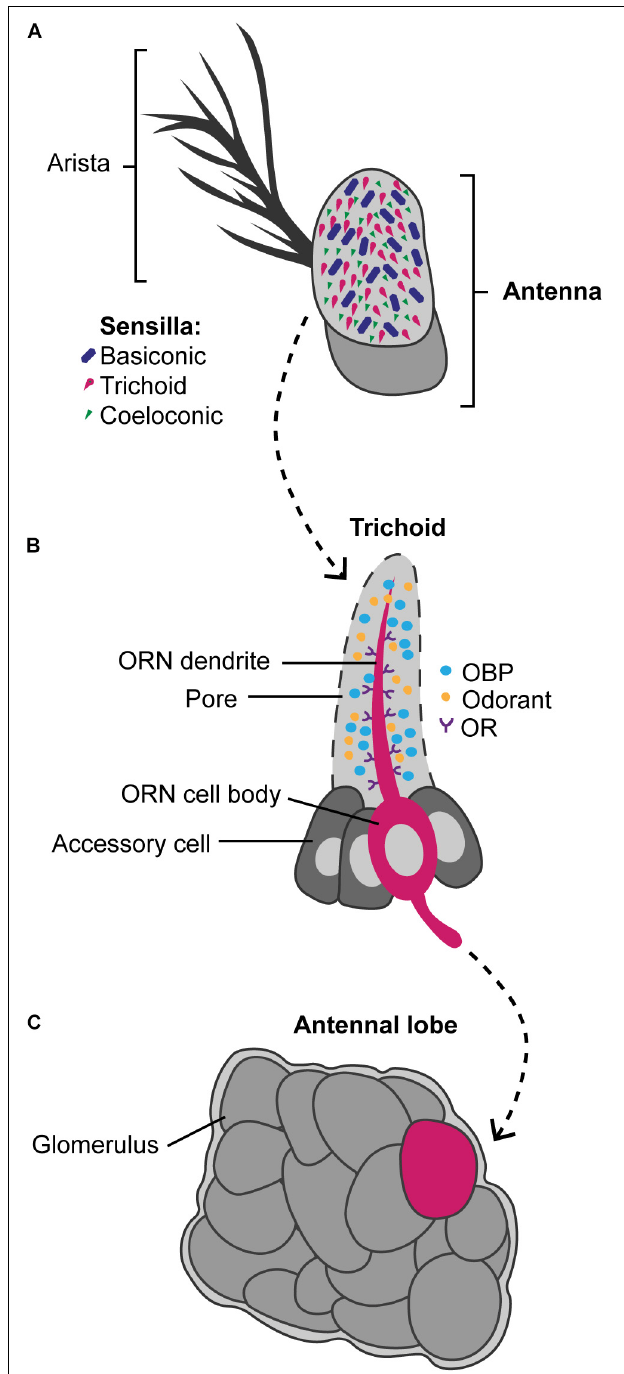
FIGURE 3 | A simplified overview showing how odors are detected by the olfactory pathway. Odors are detected by hair-like sensilla on the antennae and the maxillary palps. Panel (A) exemplifies how the antennae of Drosophila are covered with the basiconic (blue), trichoid (magenta), and coeloconic (green) sensilla types. These sensilla contain olfactory receptor neurons (ORN) that express olfactory receptors (ORs) and ionotropic receptors (IRs). Panel (B) exemplifies a trichoid sensilla in which the dendrite of the ORN (magenta) is covered with ORs (purple). In Drosophila , the ORNs can express one to